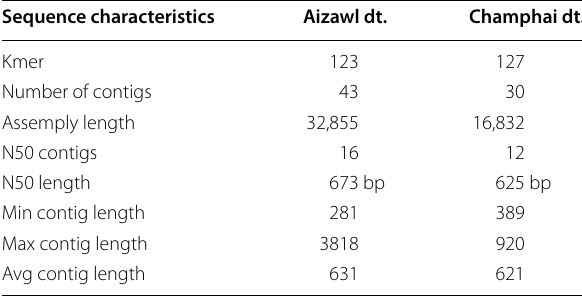
Table 3 Sequence characteristics of the composite